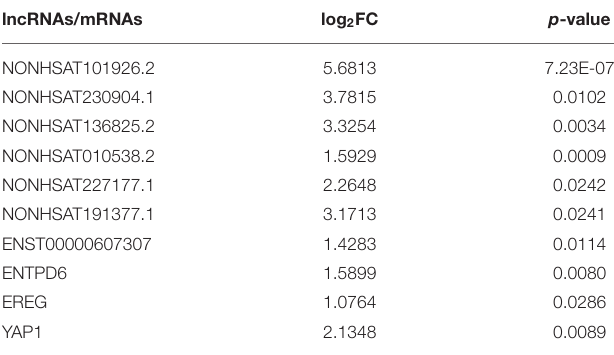
TABLE 6 | The log 2 fold-change (log 2 FC) and p -value of lncRNAs and mRNAs. lncRNAs/mRNAs log 2 FC p